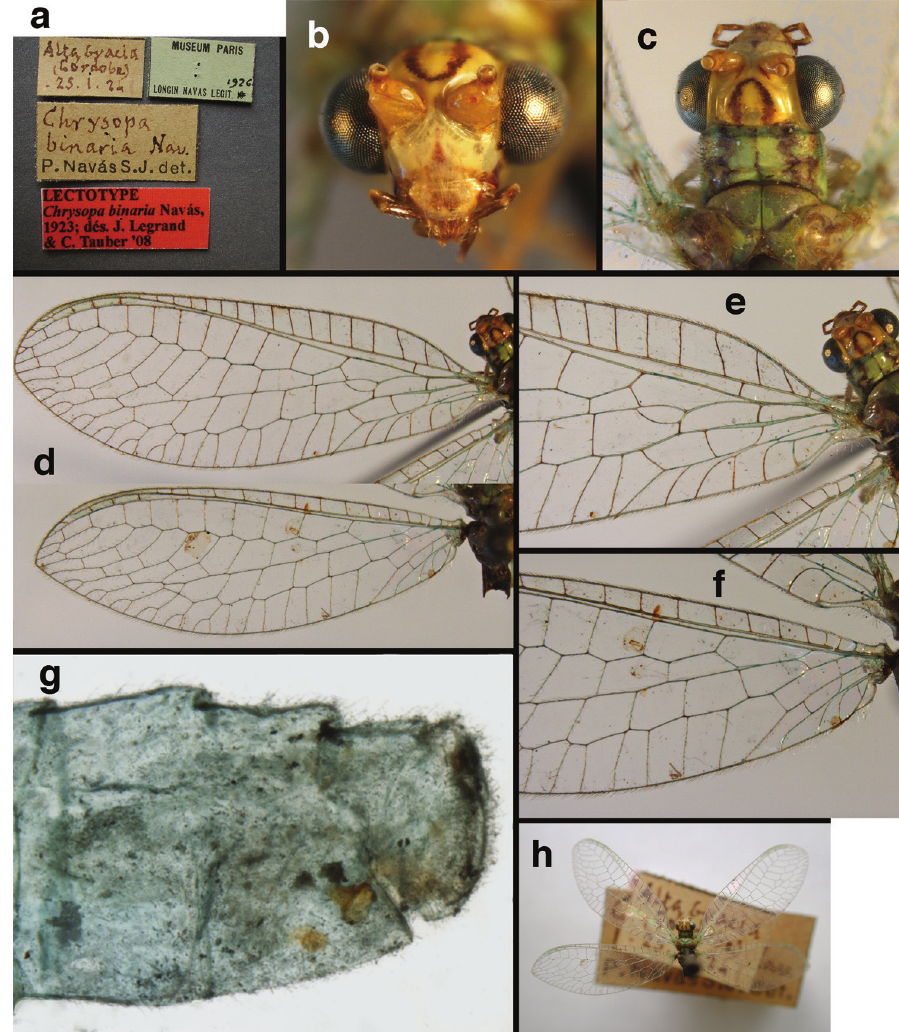
Figure 124. Chrysopa binaria Navás: External features, ( a ) labels ( b ) head, frontal ( c ) head, prothorax, dorsal ( d ) wings, left ( e ) base of forewing ( f ) base of hindwing ( g ) abdominal segments A6-terminus, lateral ( h ) habitus, dorsal (Argentina, Córdoba, lectotype, female, MNHN). brown margins. Antenna with scape cream-colored to light tan, unmarked; pedicel cream-colored to tan, with distal ring of brown; flagellum cream-colored to light tan basally, becoming darker distally; maxillary palp with basal two segments pale, mesal two segments brown dorsally, laterally, distal segment brown; labial palp with basal segment pale, distal two segments with brown. Prothorax relatively short, green mesally, with wide, brown, lateral stripes, thin, brown mesal stripe; transverse furrow in posterior region, not reaching lateral